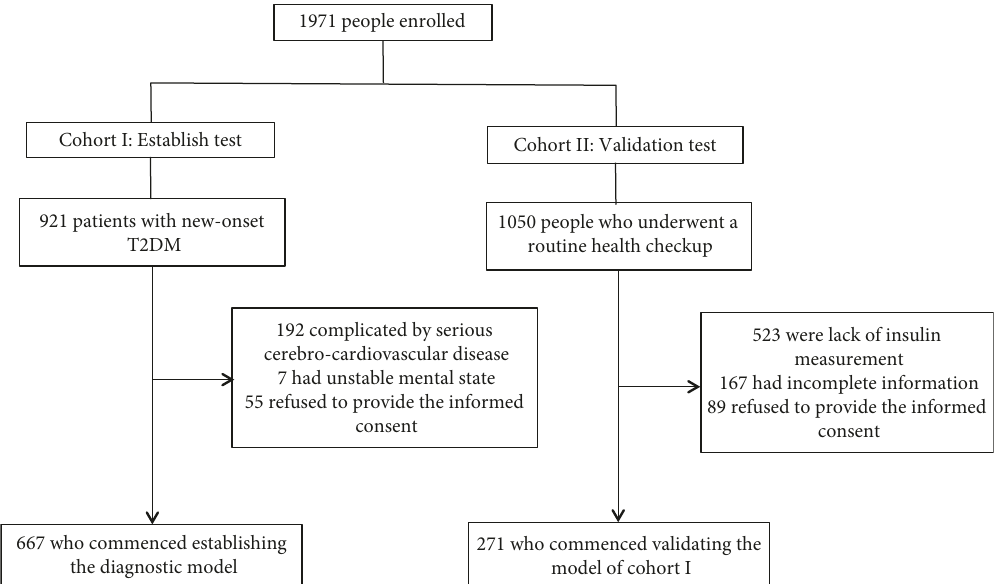
Figure 1: Flowchart of the study design and participants recruitment in this